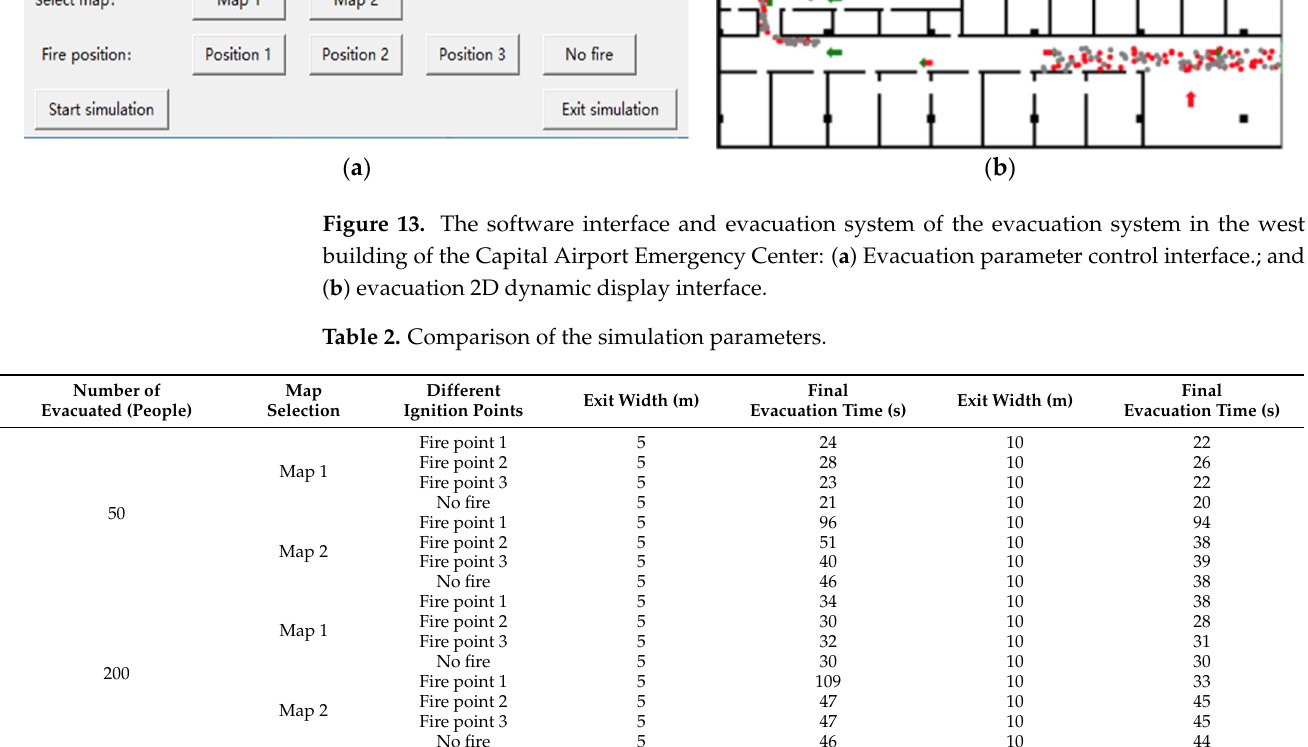
Table 2. Comparison of the simulation parameters.